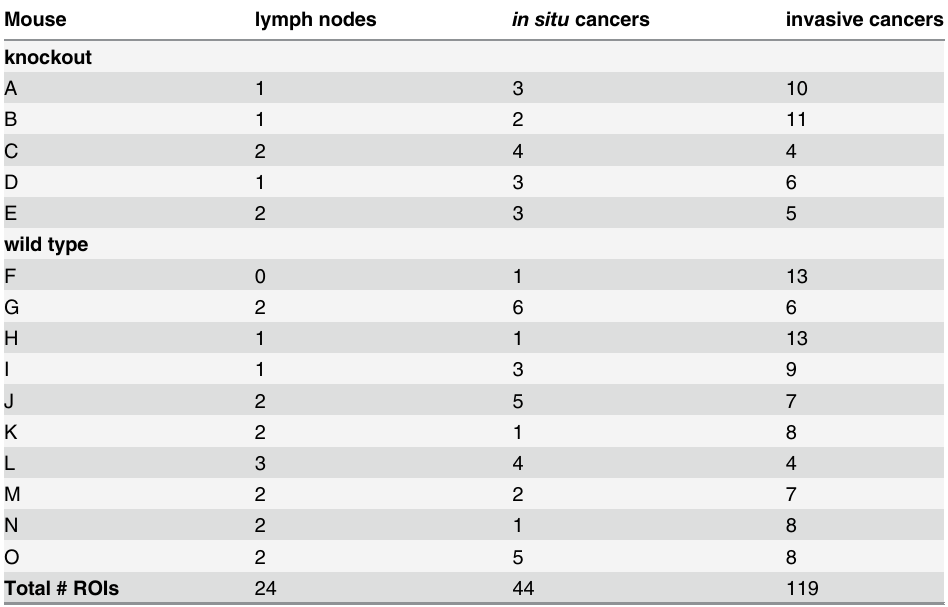
Table 1. Number of ROIs for lymph nodes, in situ cancers, and invasive cancers found in each mouse (named A to O) that matched between in vivo and ex vivo MRI experiments. Mouse lymph